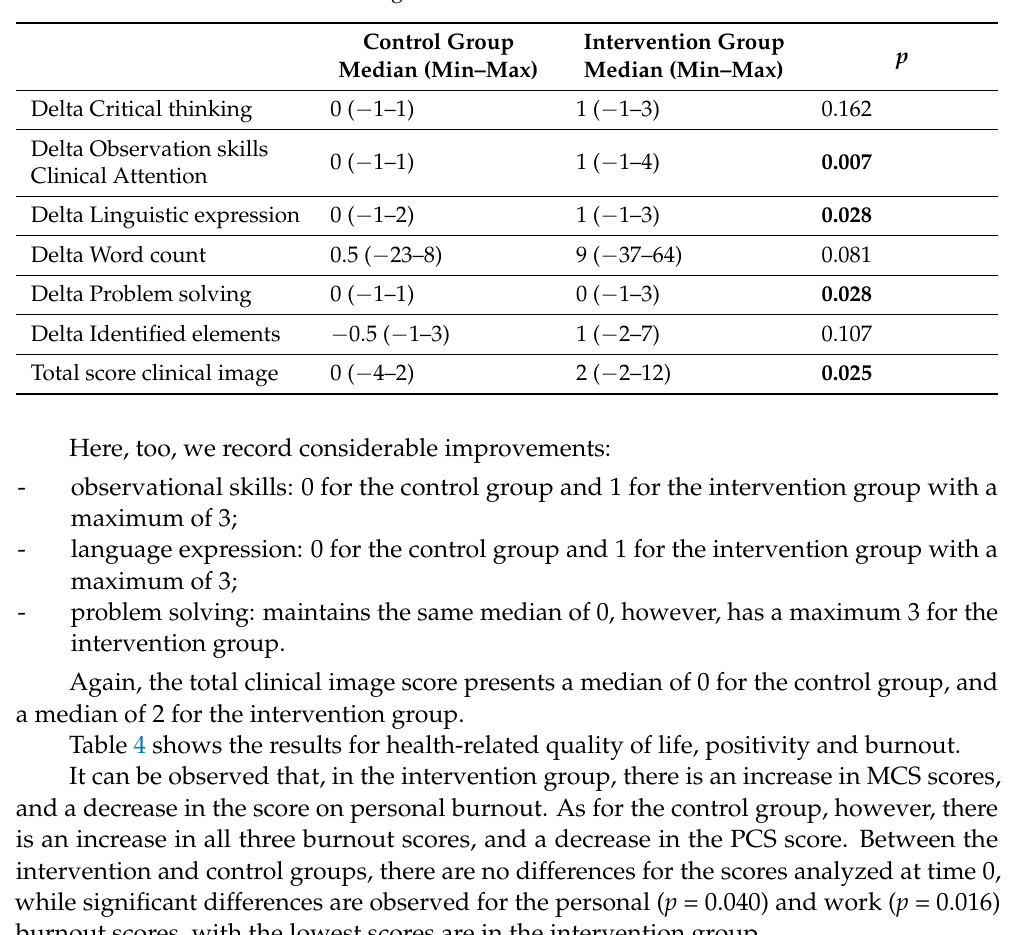
Table 3. Results related to clinical